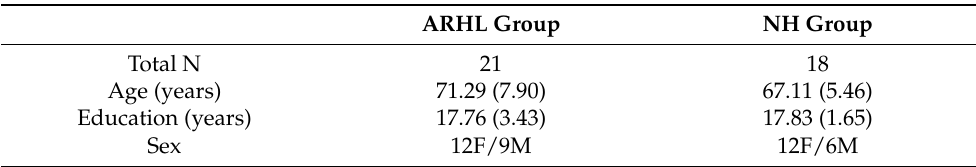
Table 1. Demographic Characteristics of